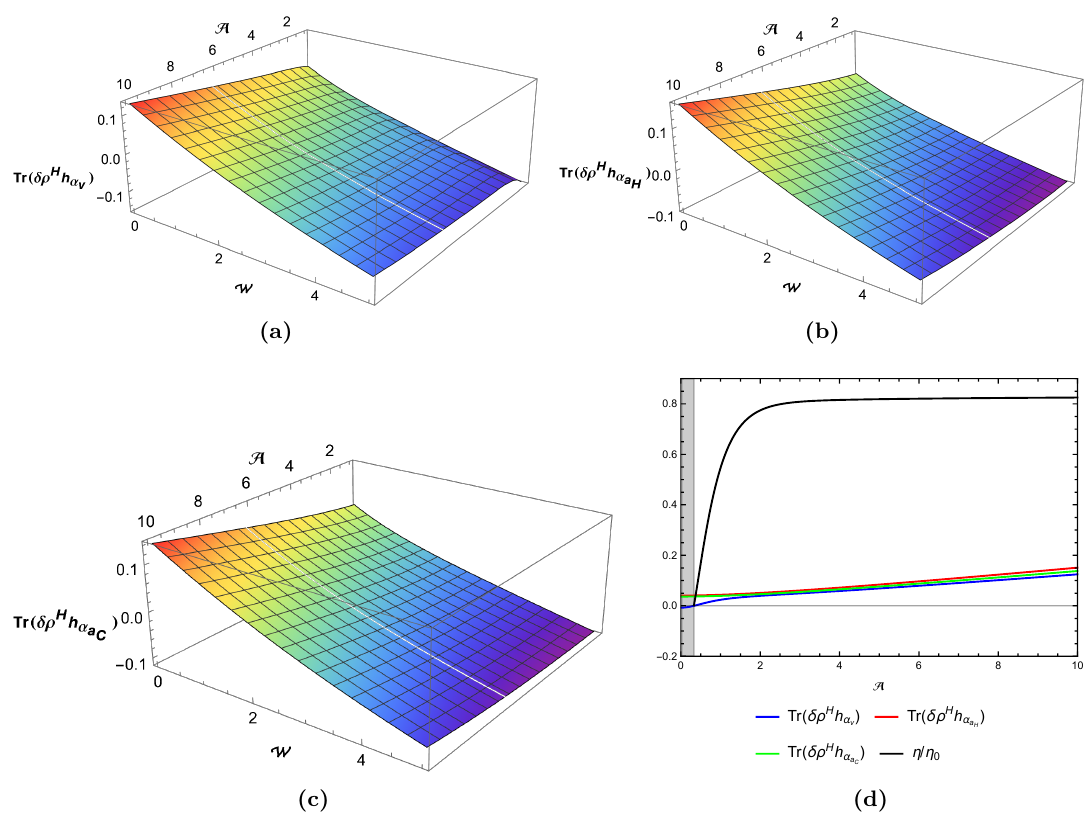
Figure 4. Initially non-maximally entangled state with | b 2 | = 0 . 9 for anti-parallel motion: plots show traces corresponding to (a) work done by the system, Tr( δρ H h ), (b) heat absorbed by the α v system, Tr( δρ H h ) with α = 0 . 2 and (c) heat rejected by the system, Tr( δρ H h ) (we chosed α aH a H α aC = 0 . 1 ) with respect to dimensionless acceleration of the primary detector ( A ) and dimensionless α a C energy gap ( W ) of the composite system. Subfigure (d) shows η/η in black line, Tr( δρ H h ) in 0 α v blue line, Tr( δρ H h ) in red line and Tr( δρ H h ) in green line with respect to dimensionless α aH α aC acceleration of the primary detector ( A ) for W = 0 . 2 , α = 0 . 2 and α = 0 . 1 . The grey region a H a C represent the regime where making of the Otto cycle is not